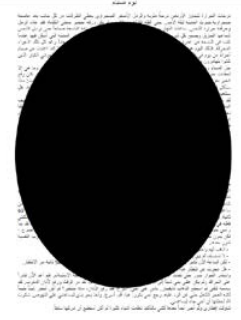
Figure 2 . A snapshot of